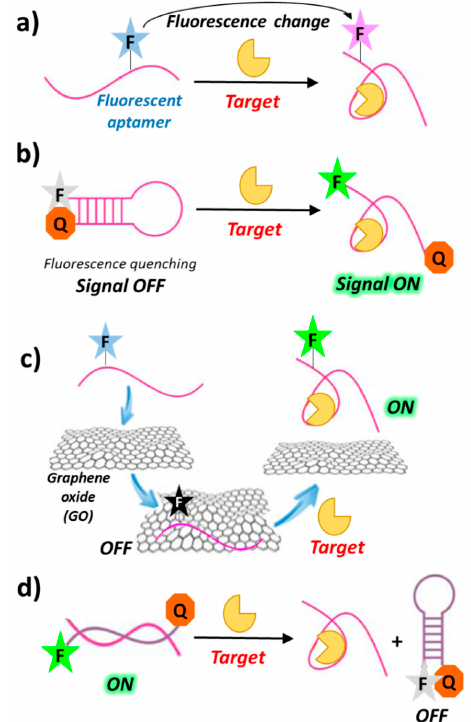
Figure 4. Schematic representation of general strategies exploited for the design of fluorescently-labelled aptamer biosensors, based on fluorescence changes ( a ), “signal-on” mode in solution ( b ) or assisted by nanomaterials ( c ) and “signal-off” mode induced by target recognition ( d ). F = fluorophore; Q = quencher; Target = protein, small molecule, ion,